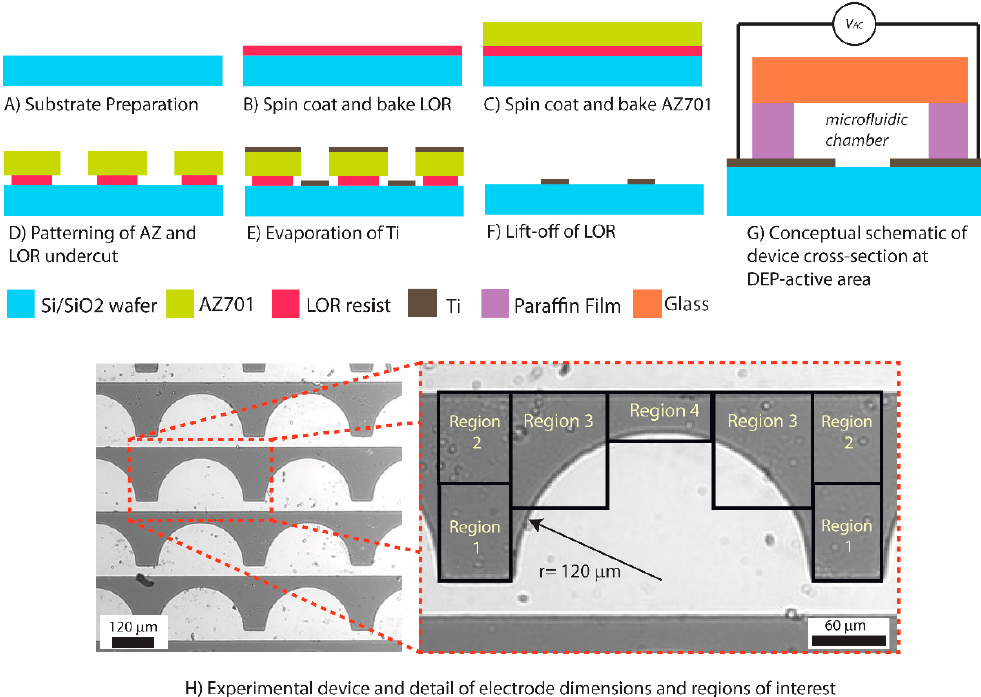
Figure 1. Fabrication of Ti electrodes: ( A ) A six-inch silicon substrate was descummed with oxygen plasma treatment at 20 uTorr. ( B ) LOR resist was spin coated at 2000 rpm for 45 s on to the silicon substrate and a soft bake was performed at 150 °C for 150 s. ( C ) AZ701 resist was spin coated at 3000 rpm for 45 s on top of the LOR resist layer and a soft bake was performed at 110 °C for 75 s. ( D ) A Quintel Ultra i-line Series machine was used to pattern the resist layers using UV light with λ = 365 nm at an intensity of 6 mW/cm 2 for 20 s. Pattern development was performed via immersion in a 2.3% tetramethylammonium hydroxide/97.7% water bath ( E ). The patterned silicon substrate was transferred to a CCS CA-40 E-beam Evaporator to deposit 350 nm of Ti. ( F ) Lastly, the wafer was immersed in NMP (1-methyl-2-pyrrolidone) to dissolve the AZ and LOR layers and effectively lift-off Ti from undesired regions of the substrate (Figure 1F). ( G ) Conceptual schematic of the cross section of an experimental device. ( H ) Experimental device and details of electrode dimensions and predefined regions of interest surrounding a single semicircular electrode.